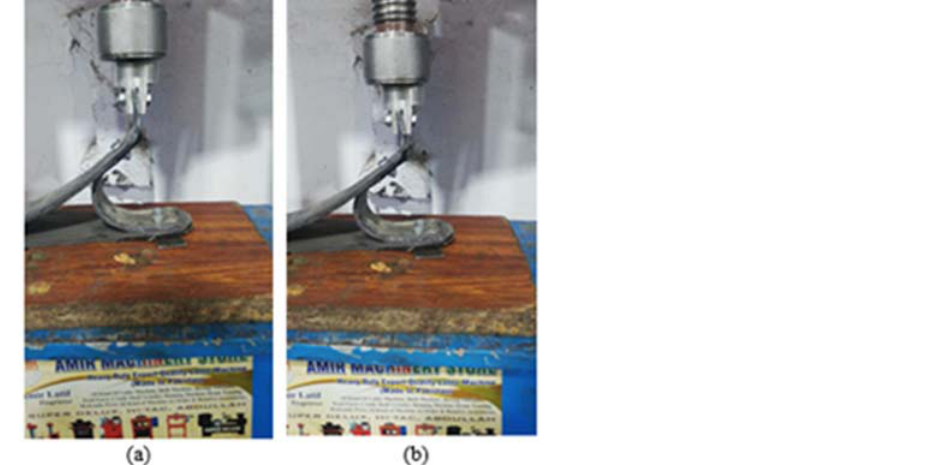
Figure 6. ( a ) Initial 0 mm displacement in the heel section; ( b ) 10 mm displacement under static load.